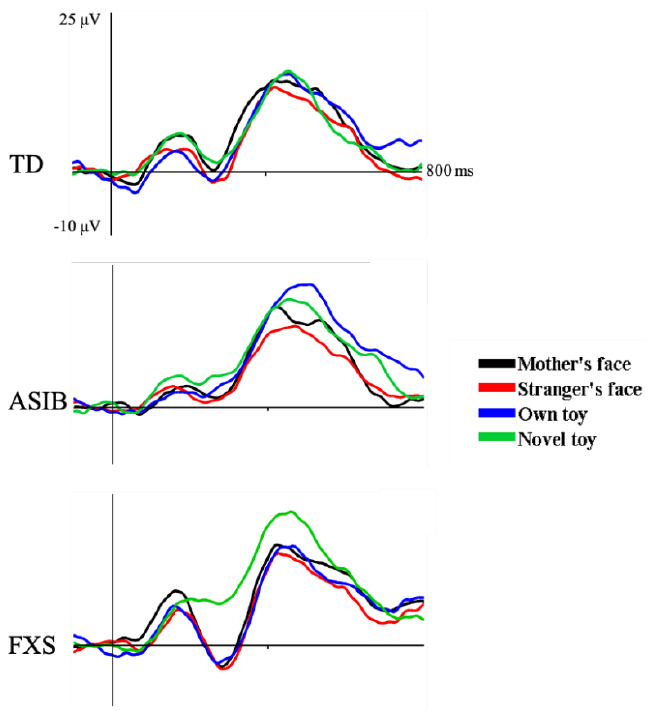
Figure 4. The N290 in response to the mother’s face, a stranger’s face, infant’s own toy, and novel toys separately for each participant group.